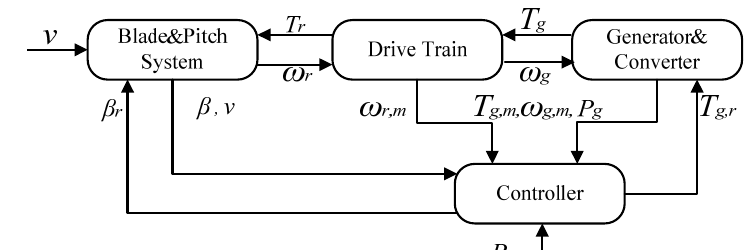
Figure 2. The control strategy for wind